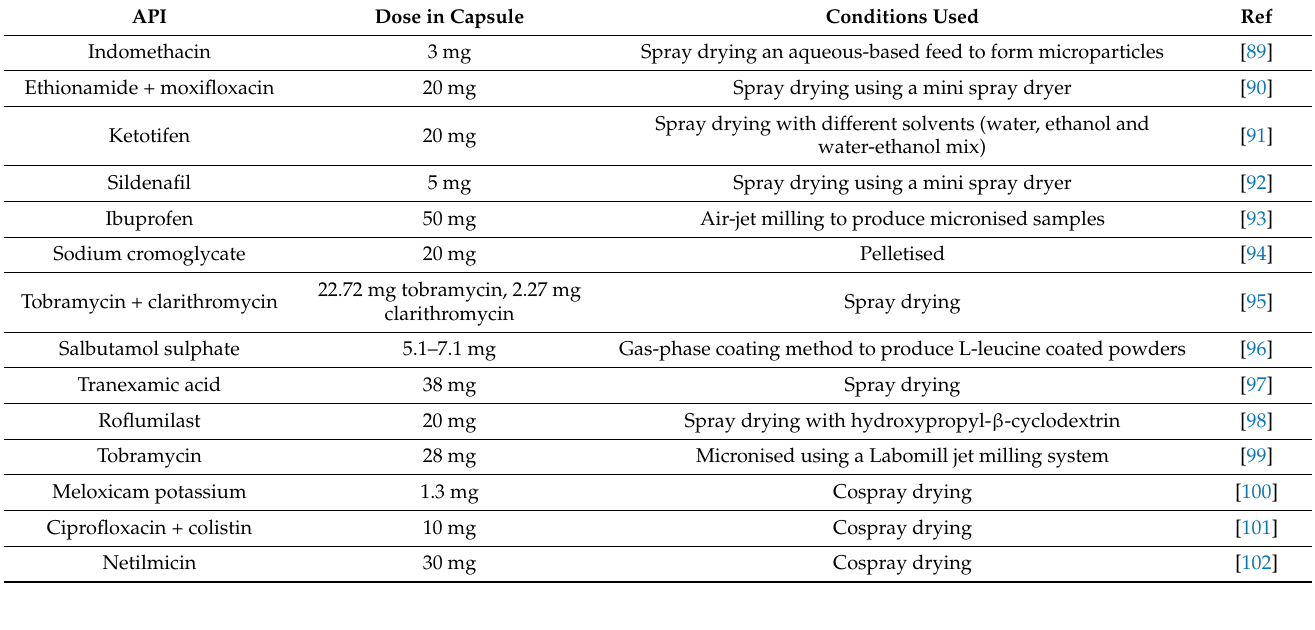
Table 6. Carrier free DPIs and the technology used to produce the powders.